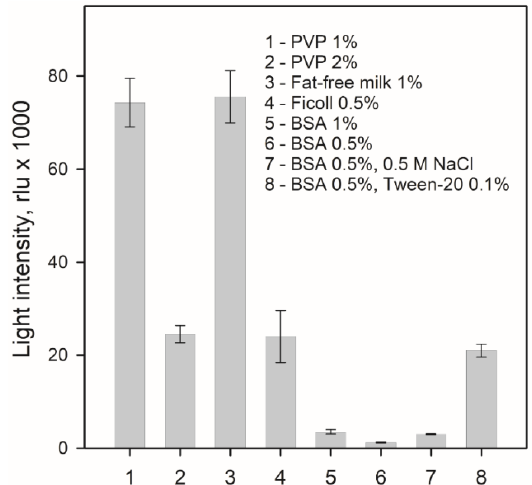
Figure A3. Background light signals assayed with various blocking solutions in PBS in model solid-phase bioluminescent assay (Figure 2a). Several blocking agents such as polyvinyl pyrrolidone (PVP) (Sigma-Aldrich, St. Louis, MO, USA), fat-free dry milk, Ficoll, and BSA in various concentrations with additives of NaCl and Tween-20 were tested. The bars indicate standard deviation ( n = 3).